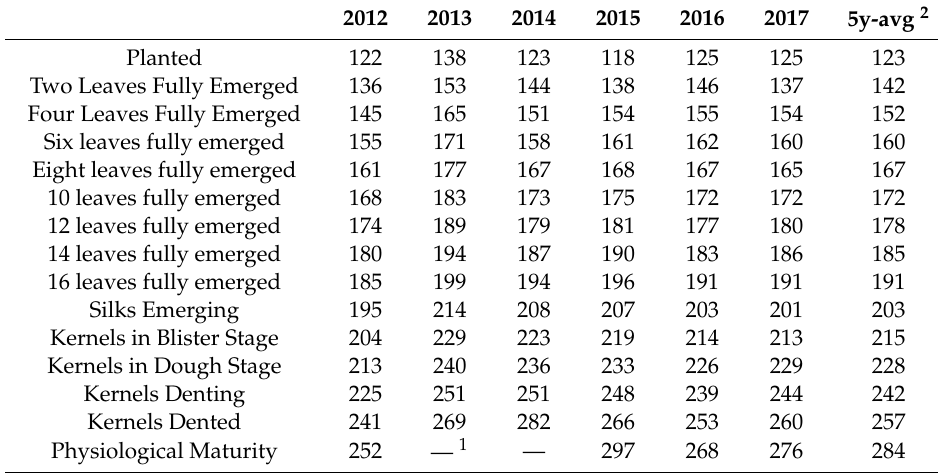
Table 2. ∆ AAT-aligned corn growth stages identified in Julian days in Carroll County from year 2012 to 2017.